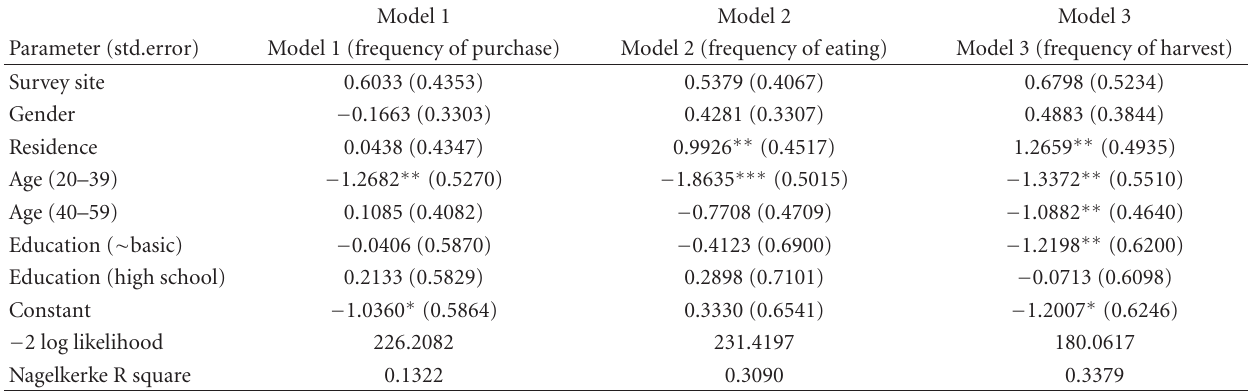
Table 5: Binary logistic model: e ff ects of age, education, and city of residence on behavior of purchasing, collecting, and eating edible wild plants.